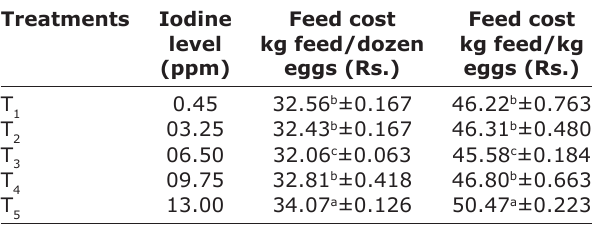
Table-4: Economics of feeding for production of iodine enriched eggs.